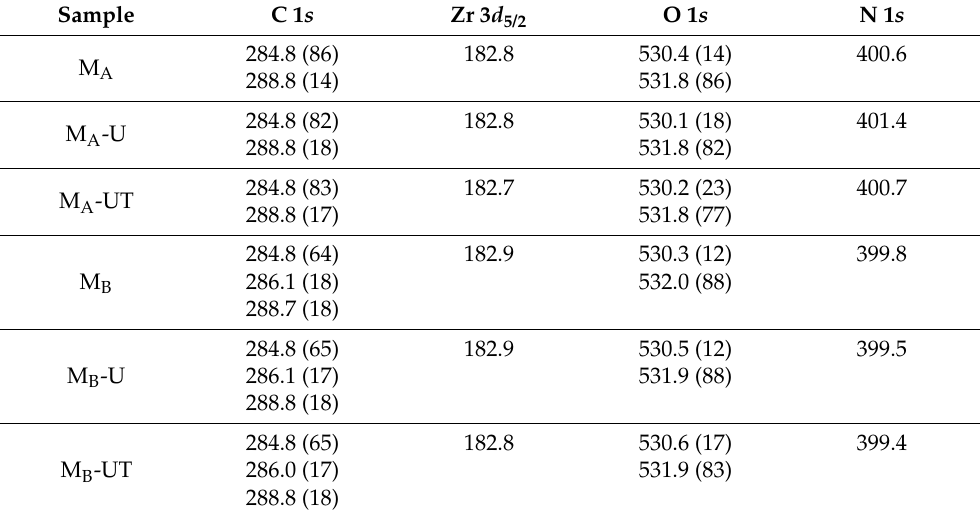
Table 3. Binding energy values (in eV) of different elements for the studied catalysts. Area percentages are indicated in parentheses.